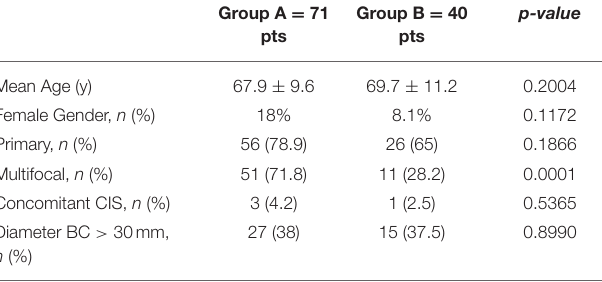
TABLE 2 | Patients’ characteristics.